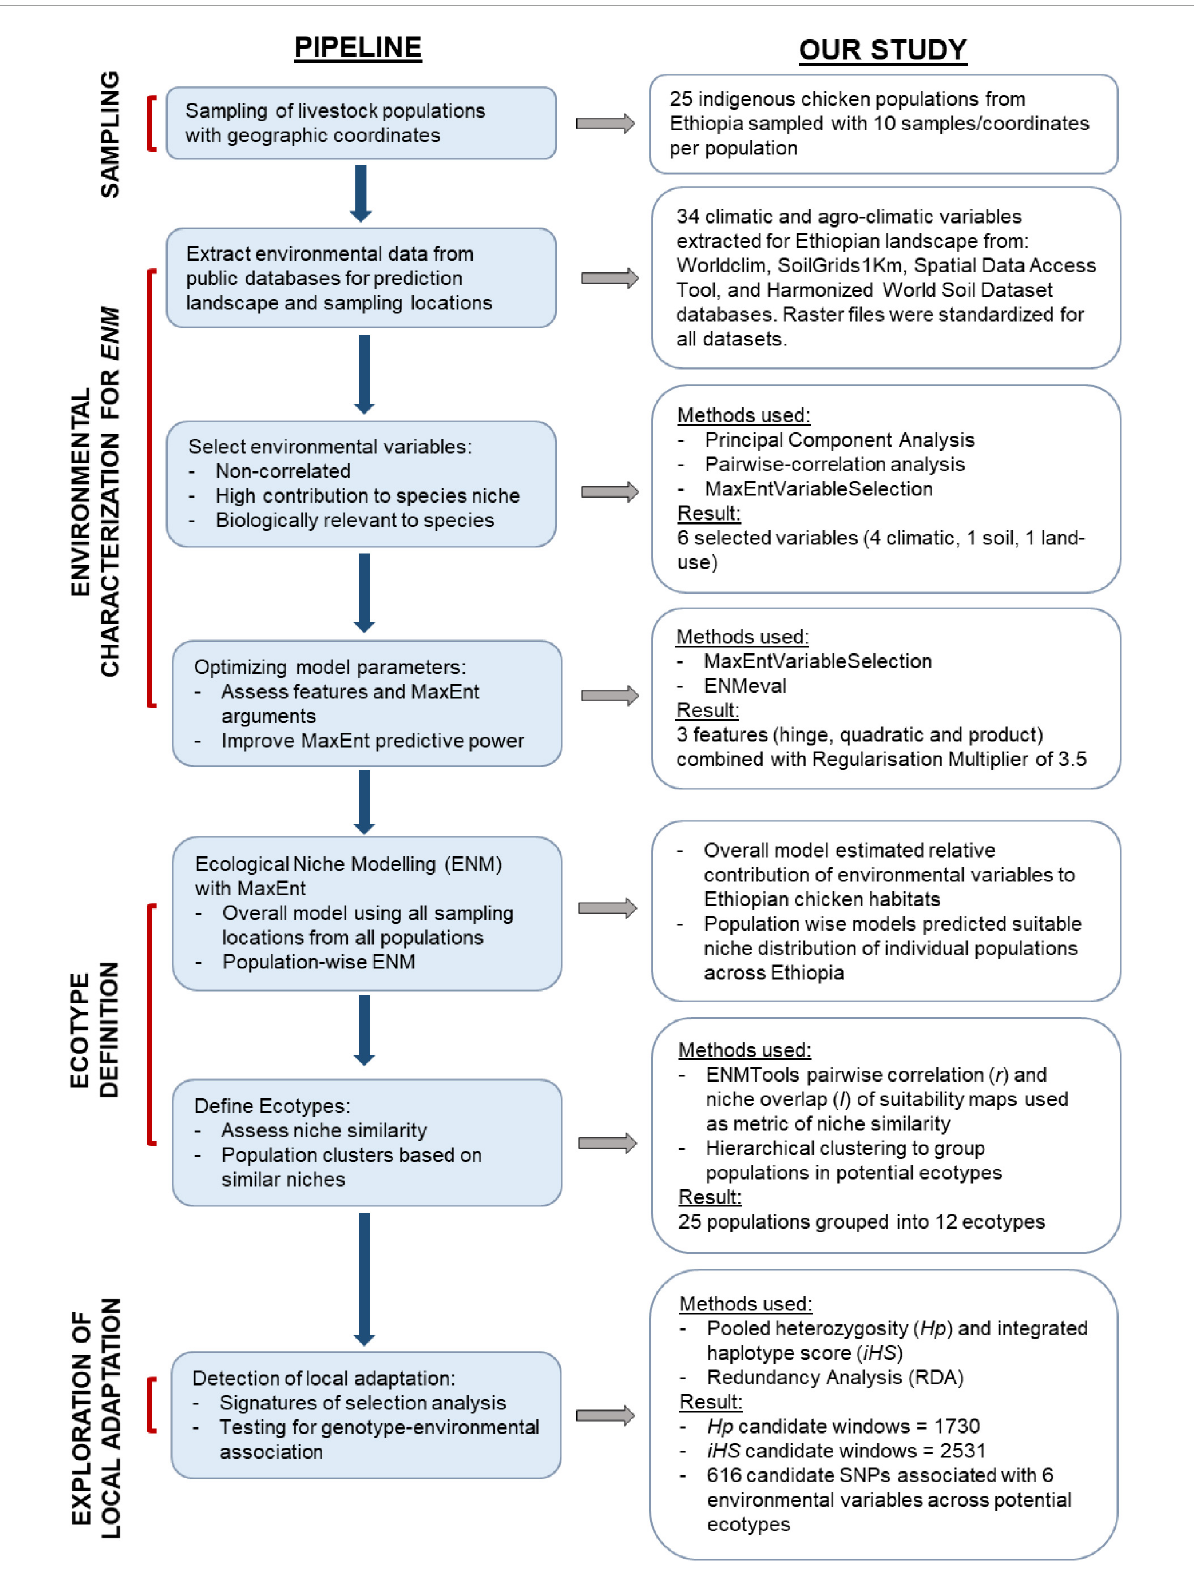
FIGURE1 A framework for defining livestock ecotypes based on ENM approach and exploring genomic adaptation to the environment.